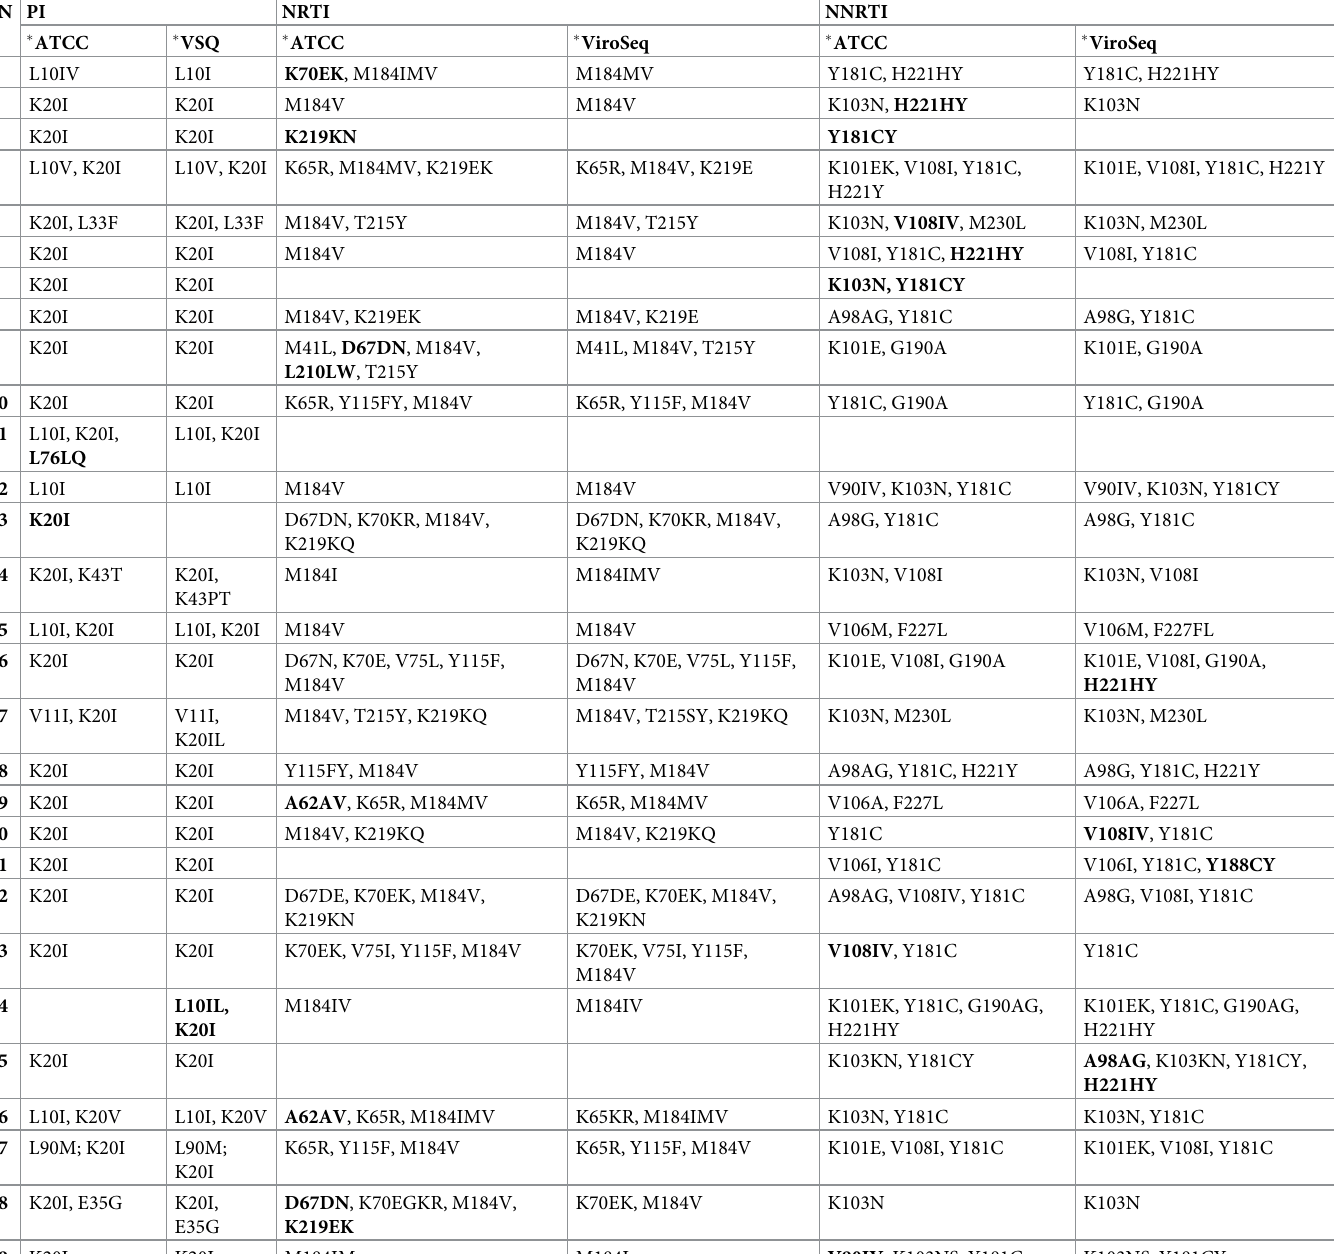
Table 2. HIV-1 Drug Resistance mutations against nucleotide reverse transcriptase inhibitors (NRTI), non-nucleotide reverse transcriptase inhibitors (NNRTI) and protease inhibitors (PI) identified by the ATCC assay versus the ViroSeq assay for those individual patients harbouring drug resistance